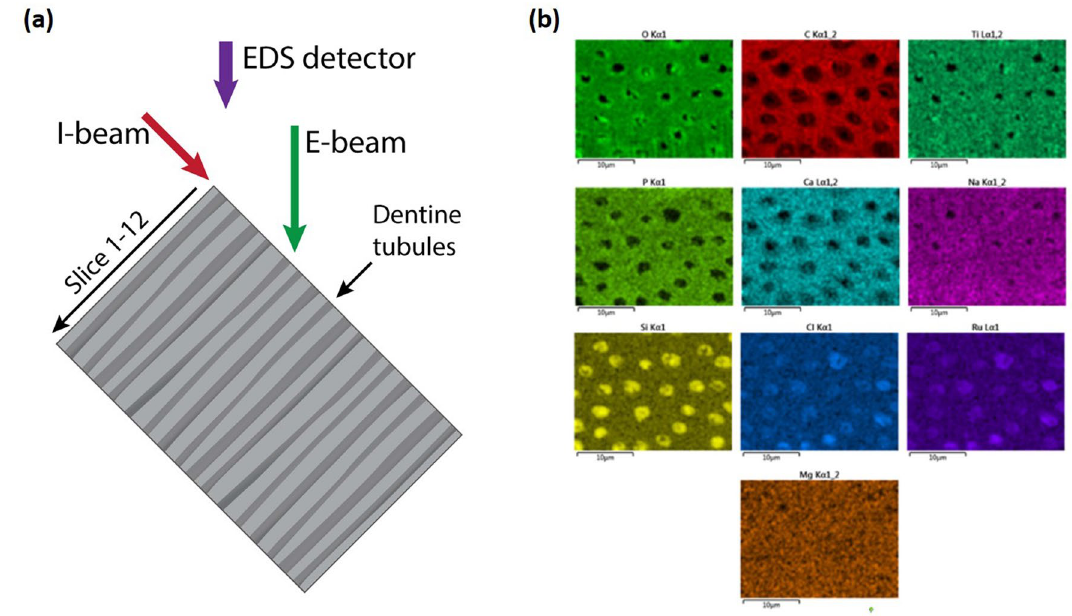
Figure 5. ( a ) Procedure for obtaining the elemental maps of the treated dentine at different depths. ( b ) A typical EDS mapping of the stained dentine disk at a mill depth of 2 µm, showing the presence of O, C, Ti, P, Ca, Na, Si, Cl, Ru, and Mg.